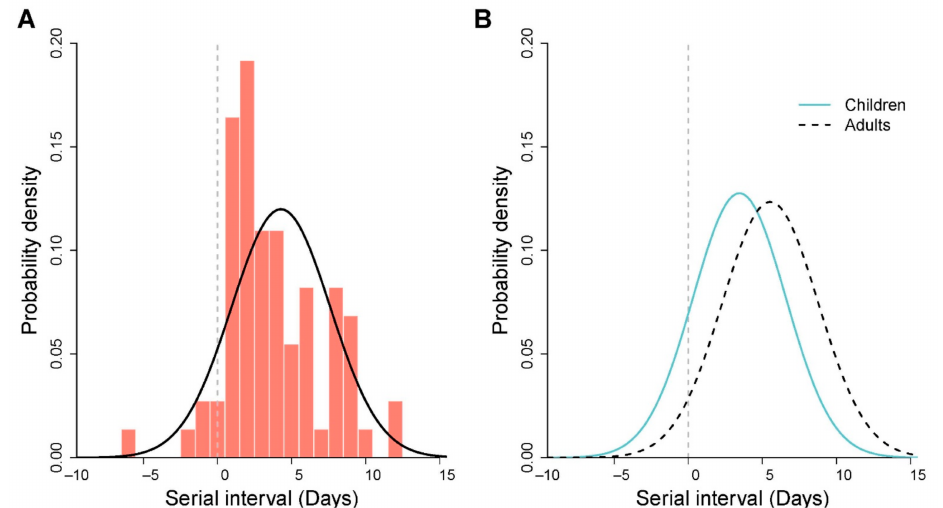
Figure 2. Estimated serial interval distributions of the SARS-CoV-2 omicron variant in South Korea. ( A ) The estimated serial interval distribution was analyzed using the 73 infector–infectee pairs. The vertical red bars indicate the empirical density of the serial intervals calculated from transmission pair data, and the solid black curve indicates fitted normal distribution. Gray vertical lines indicate the presymptomatic transmissions. ( B ) The estimated serial interval distributions were analyzed by two different age groups of infectors. The fitted serial interval distributions (normal) for child infectors ( n = 44 pairs) in solid blue curve and adult infectors ( n = 29 pairs) in dashed black